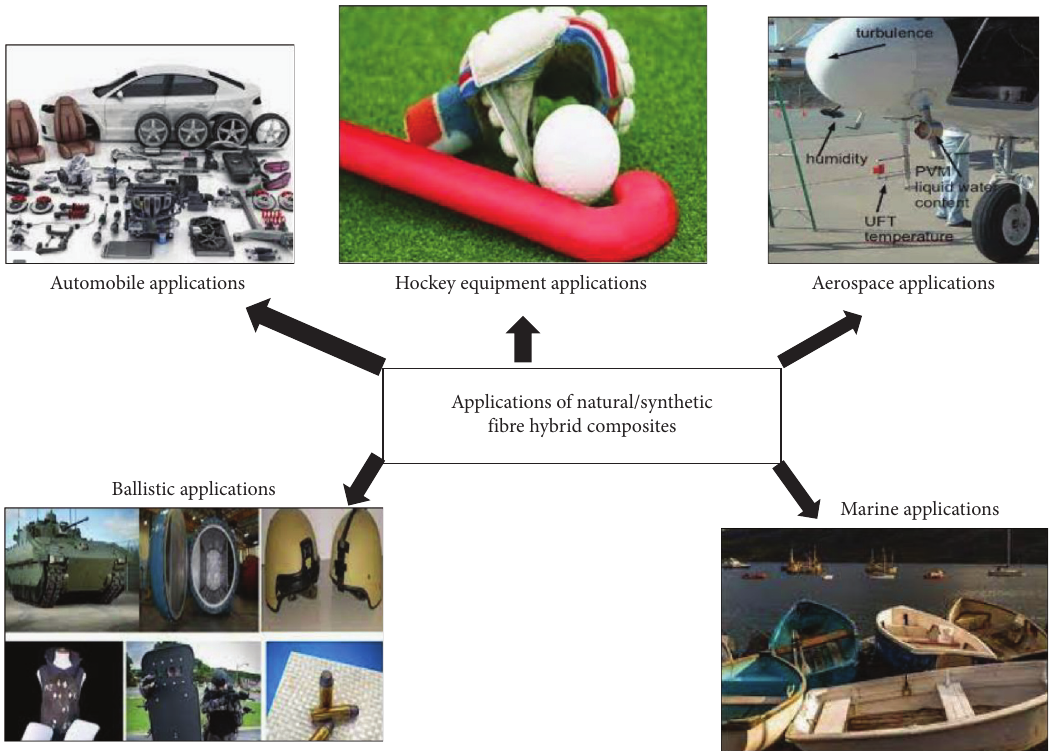
Figure 10: Application areas of natural/synthetic fibre hybrid reinforced polymer